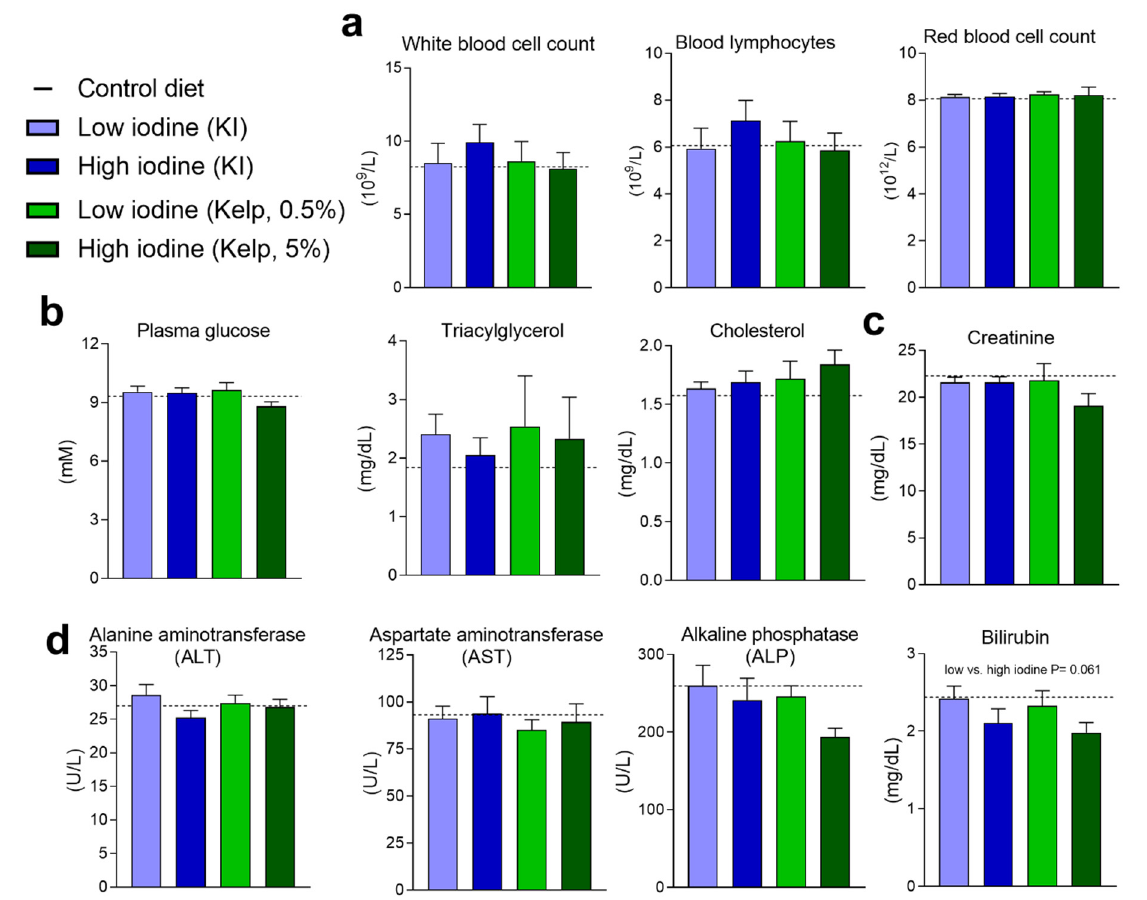
Figure 6. Blood haematology and plasma measurements: ( a ) White blood cells, blood lymphocytes, and red blood cells measured after 13 weeks of dietary treatment. ( b ) Plasma measurements of glucose, triacylglycerol and cholesterol, ( c ) creatinine and ( d ) alanine aminotransferase, aspartate aminotransferase, alkaline phosphatase, and bilirubin. Data are presented as mean ± SEM ( n = 8–10). Data were analysed using a standard two-way ANOVA in GraphPad Prism.